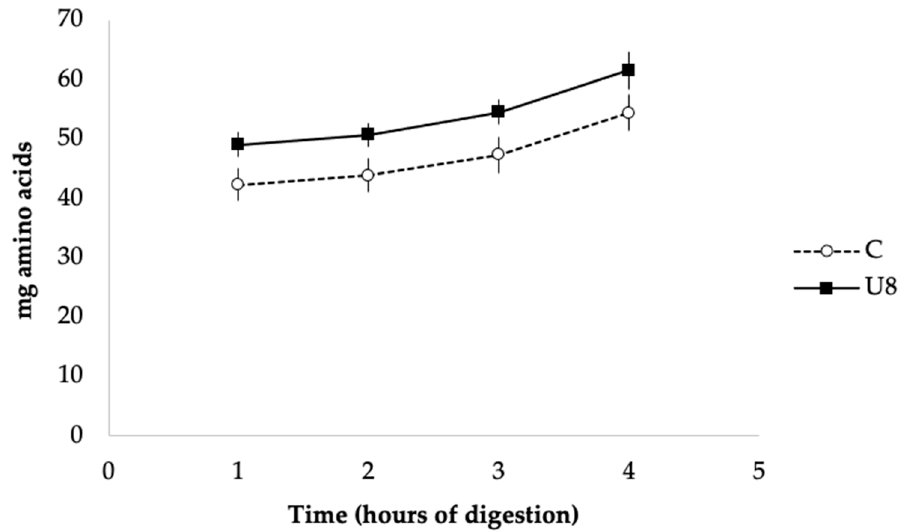
Figure 4. Time release of total amino acids in the in vitro simulation of the digestion of feed, in- cluding 8% U. ohnoi meal (U8) and without macroalgae (C). Each point represents the average value of three determinations ± SD.